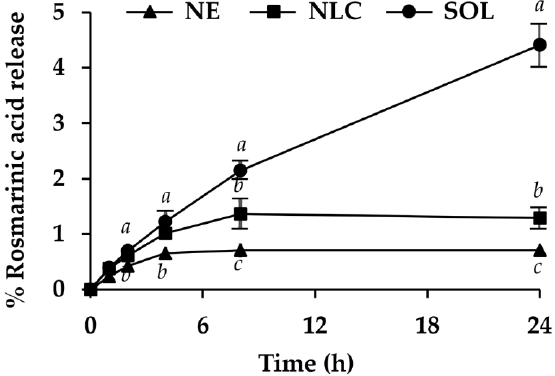
Figure 10. Rosmarinic acid (RA) release profile of nanoemulsion containing 0.1% w / w O. sanctum ethanolic extract (NE), nanostructured lipid carriers containing 0.1% w / w O. sanctum ethanolic extract (NLC), and 0.1% w / w O. sanctum ethanolic extract in propylene glycol (SOL): The letters a, b, and c denote significantly different content of rosmarinic acid (RA) released at each time interval ( p < 0.05).